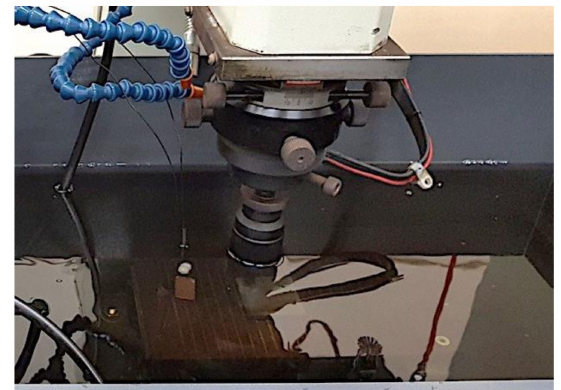
Figure 7. Photo of the EDM process.